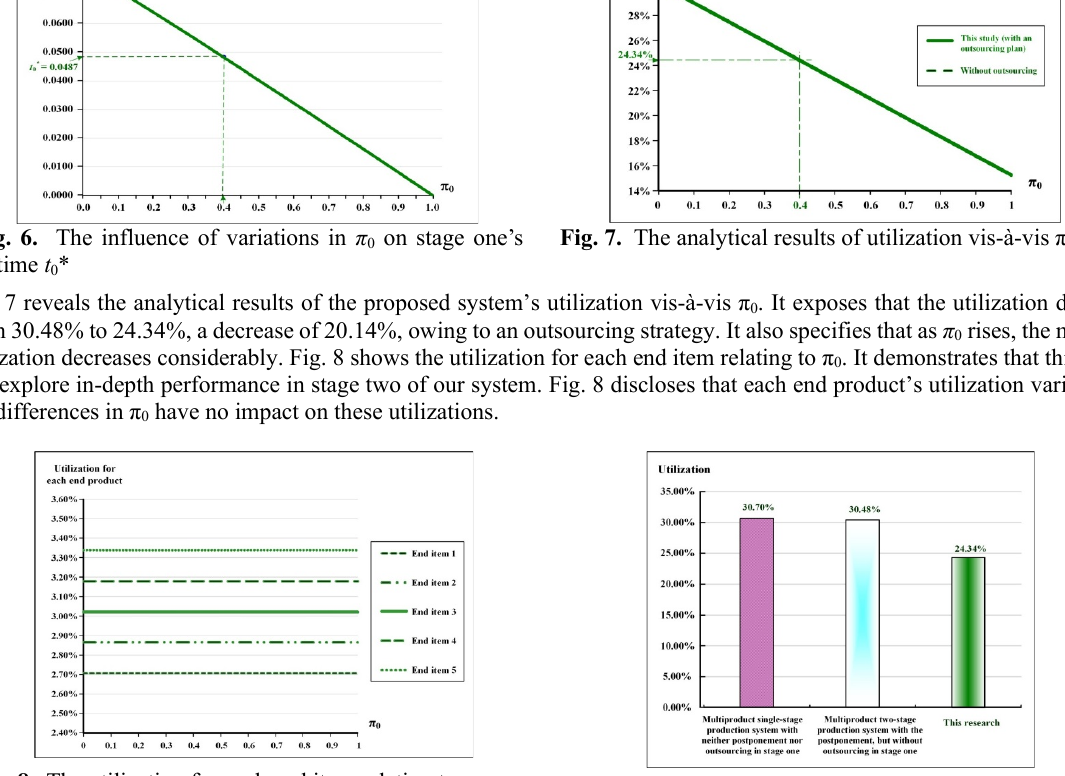
different models